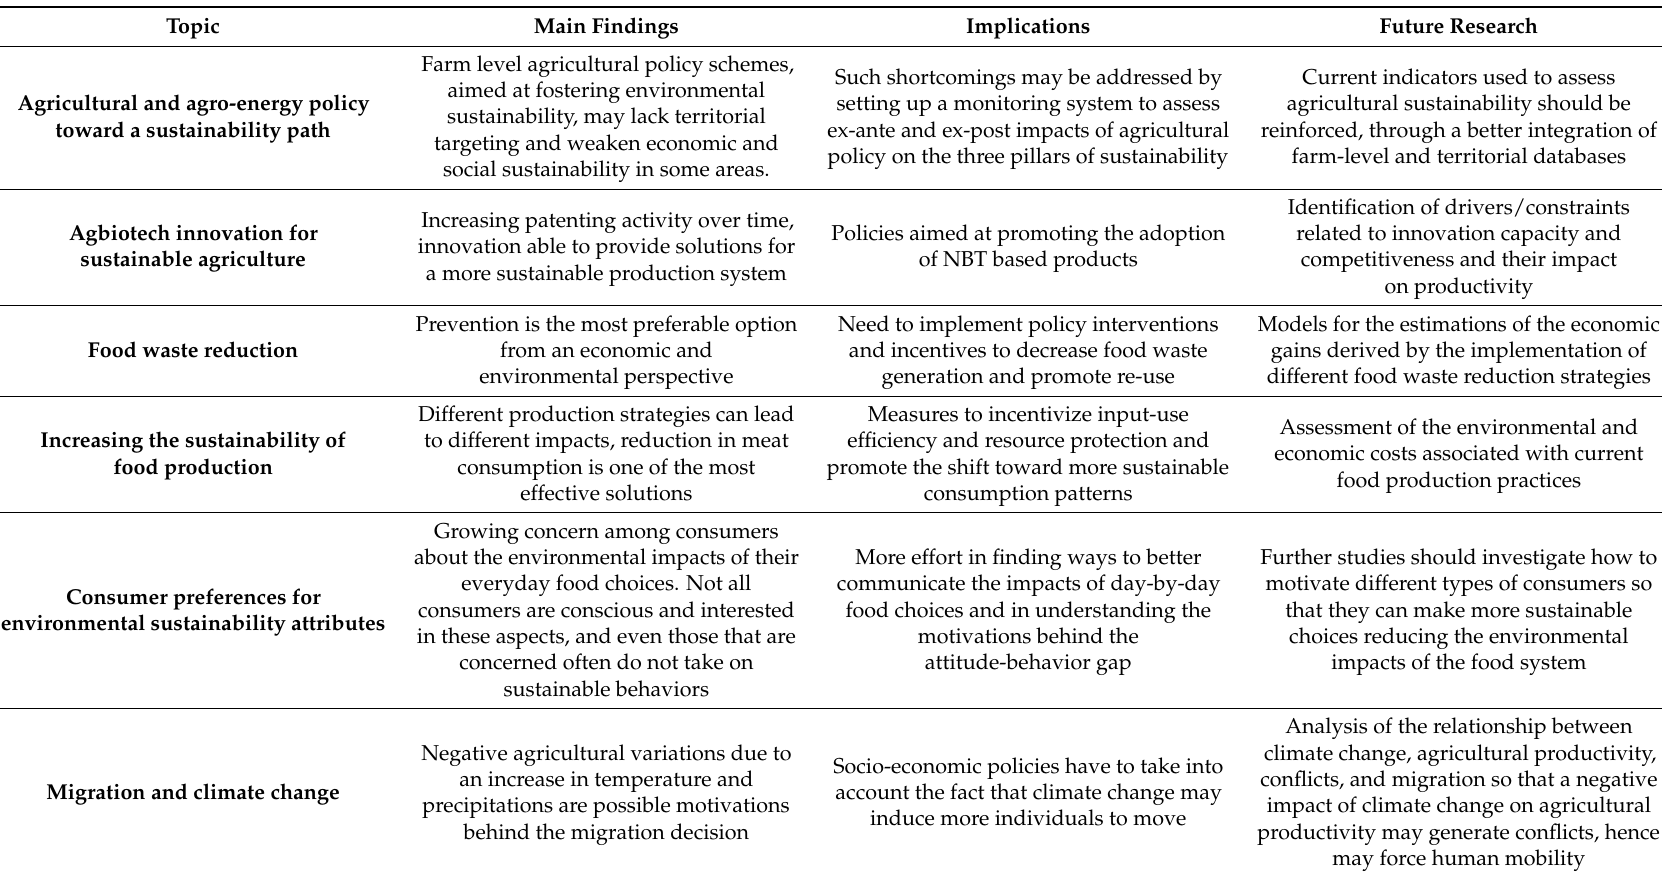
Table A1. Summary of major findings, implications, and future research insights for the different topics